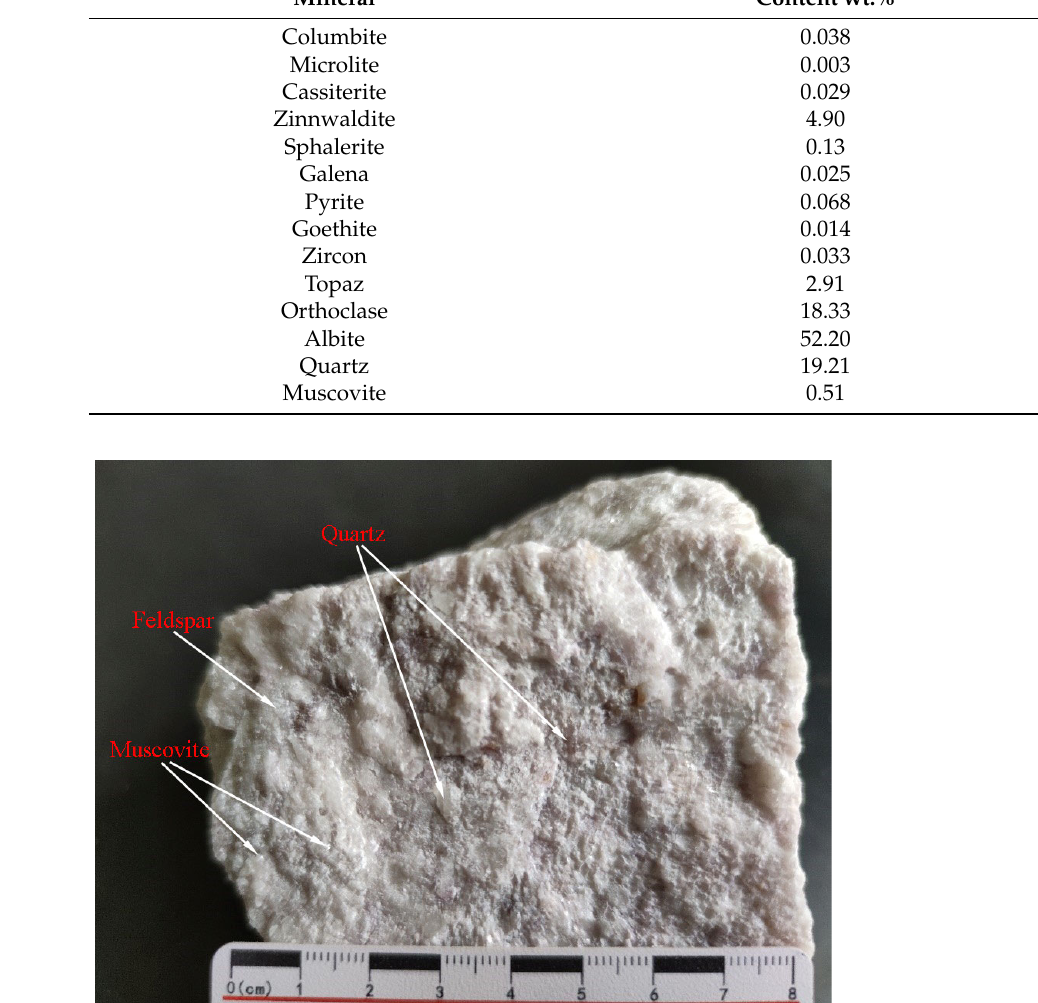
Figure 4. Microscopic characteristics of the ore. (From this perspective, albite is the main gangue mineral bearing conspicuous lamellar bi ‐ crystals; quartz particles are coarse and semi ‐ automorphic; the particle size distribution of muscovite is uneven, and the interference color is bright).